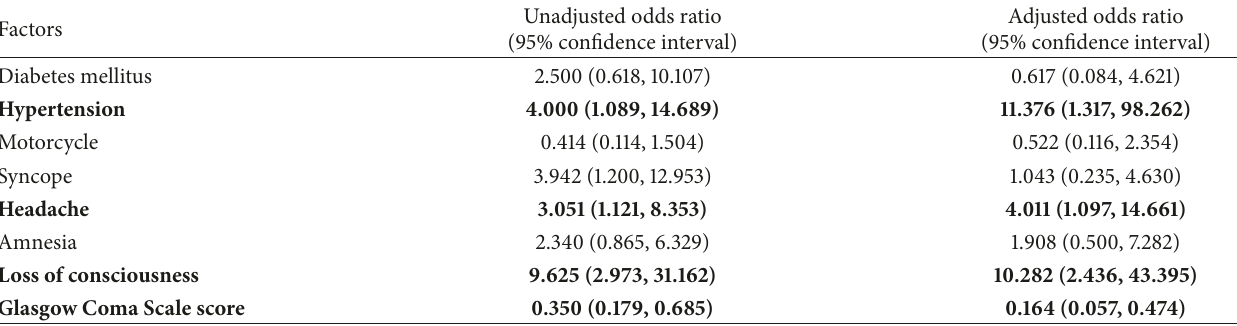
Table 3: Significant factors associated with intracerebral hemorrhage as diagnosed using computed tomography of the brain in head injury patients who were moderate risk for intracranial